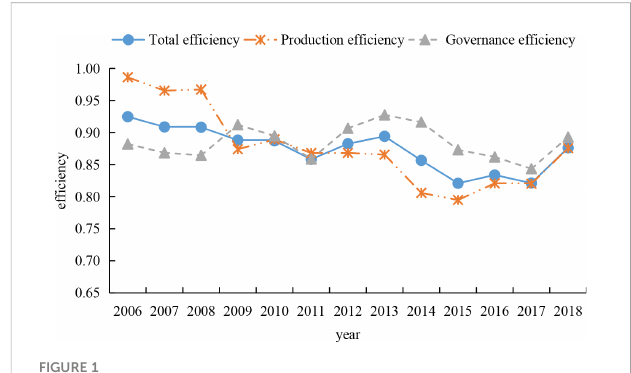
FIGURE 1 Trends of marine green economy ef fi ciency in different stages from 2006 to